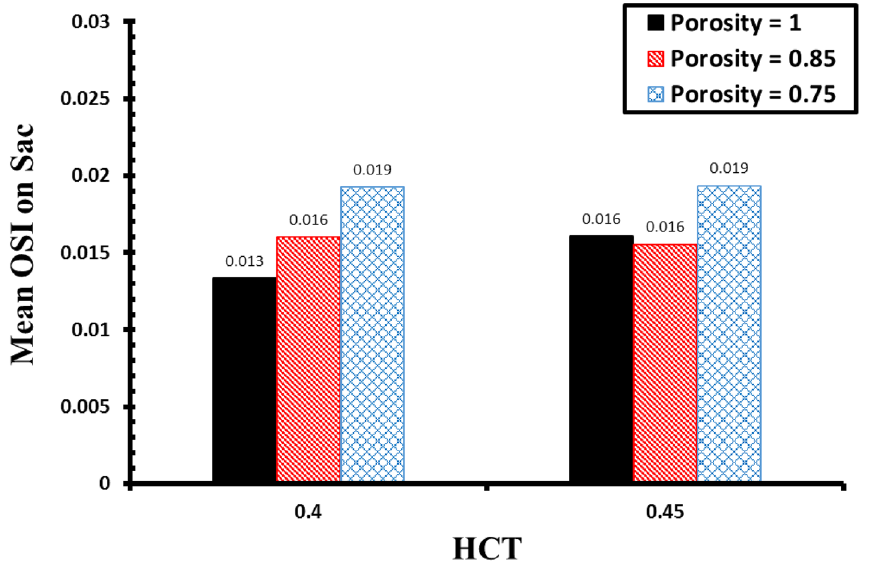
Figure 12. Impacts of HCT and coiling porosity on OSI at end of blood cycle (t = 0.54